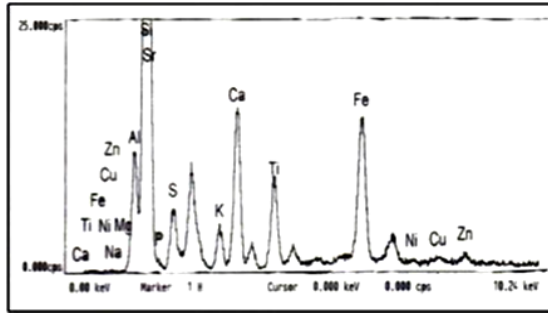
Fig. 5. The X-ray fluorescence spectrogram of coal Fig. 6. The X-ray fluorescence spectrogram of